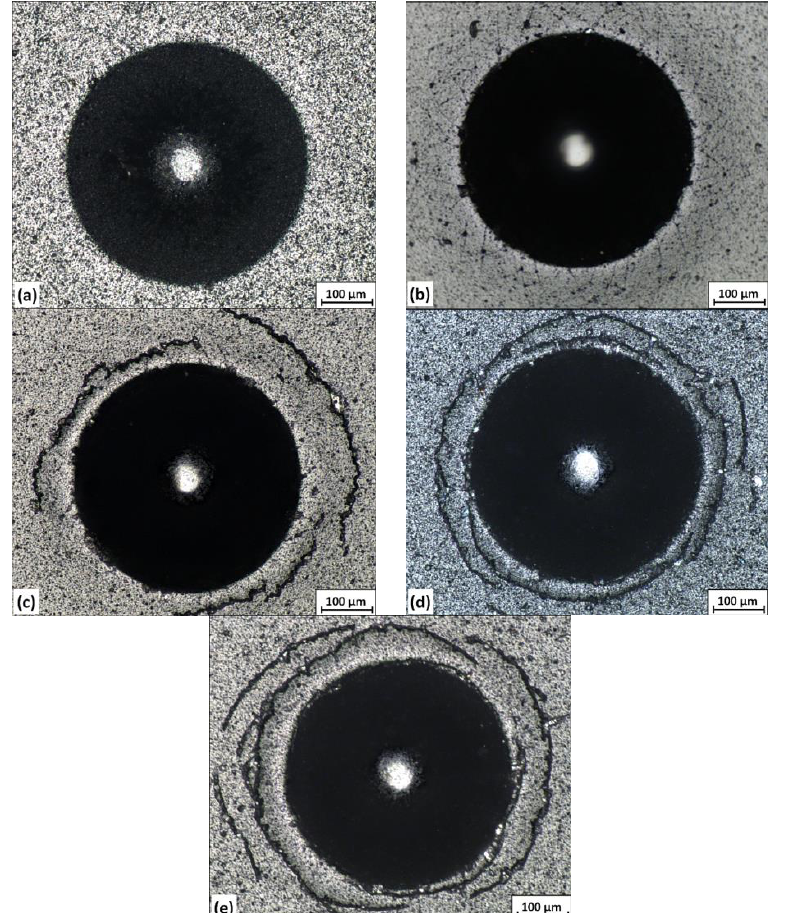
Figure 7. The images of indentations in the Daimler-Benz test of AlCrSiN coatings formed from cathodes with silicon concentrations: ( a ) 0 at%, ( b ) 1 at%, ( c ) 2 at%, ( d ) 5 at% and ( e ) 10 at%.